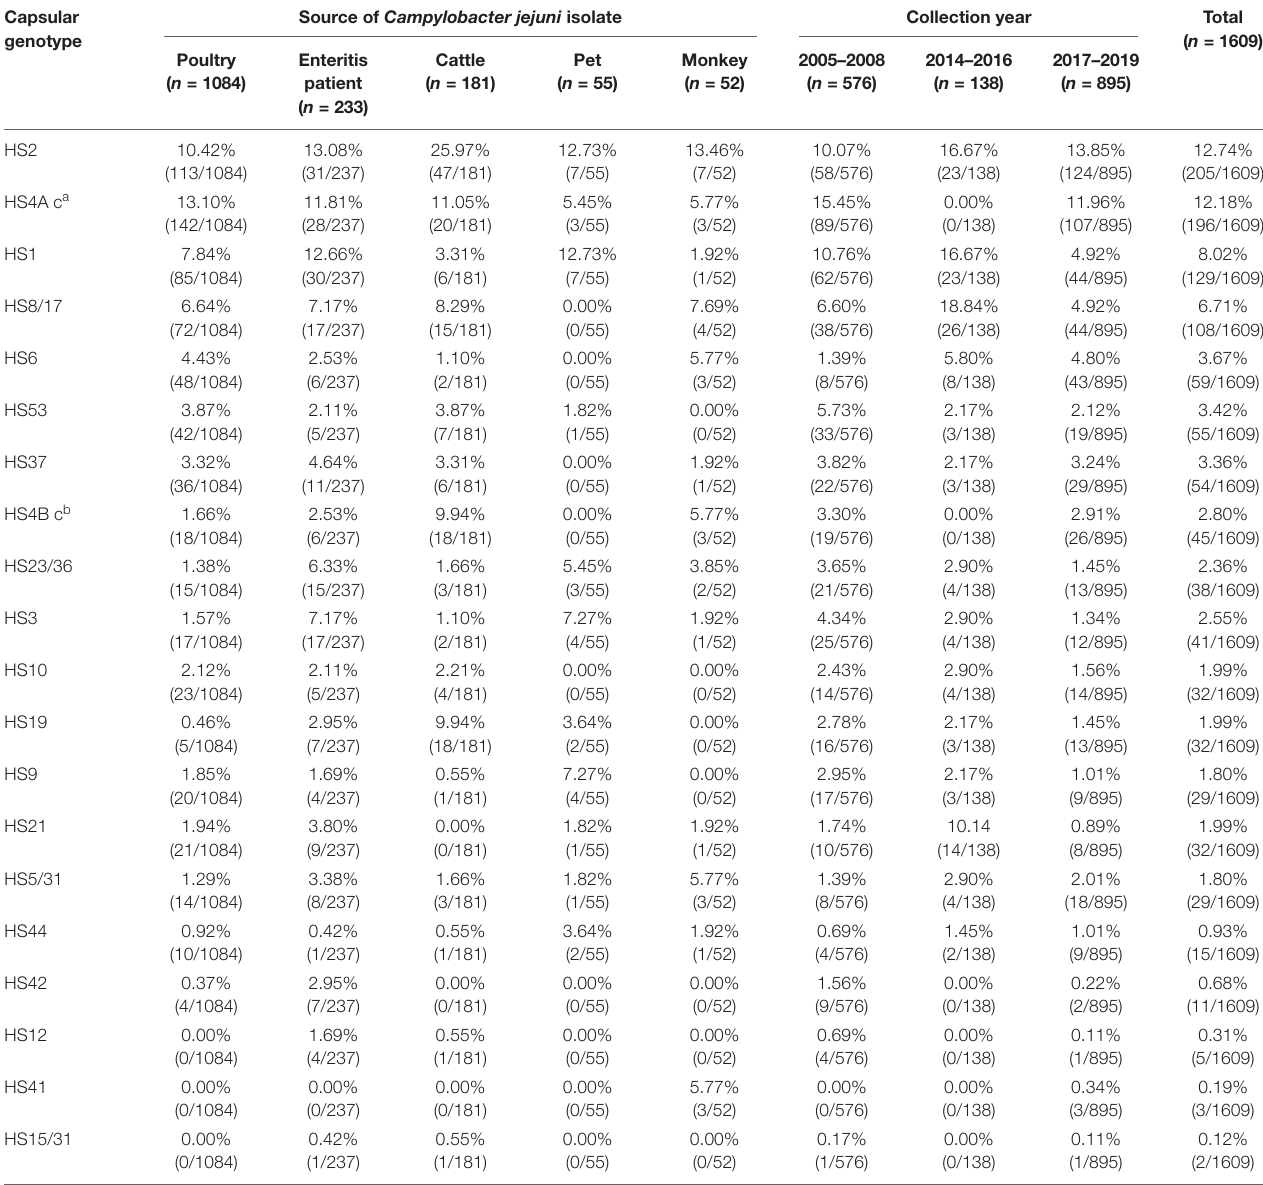
TABLE 1 | Comparison of capsular genotype with proportional estimates by Campylobacter jejuni isolates source and collection year. Capsular